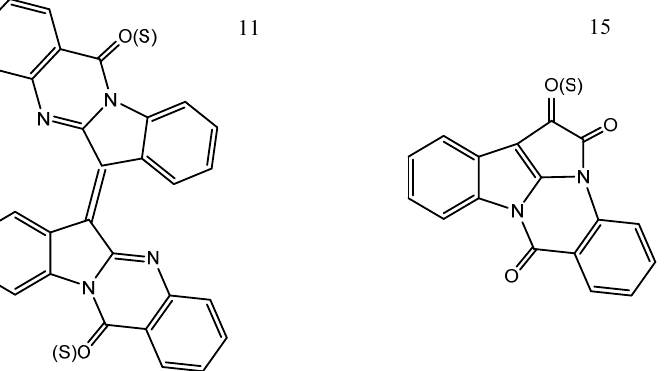
Figure 2. Proposed structures of side products from the isatin/indirubins synthetic procedure applied to tryptanthrin. Table 1. Synthesised quingdainone variants with their respective substituents.